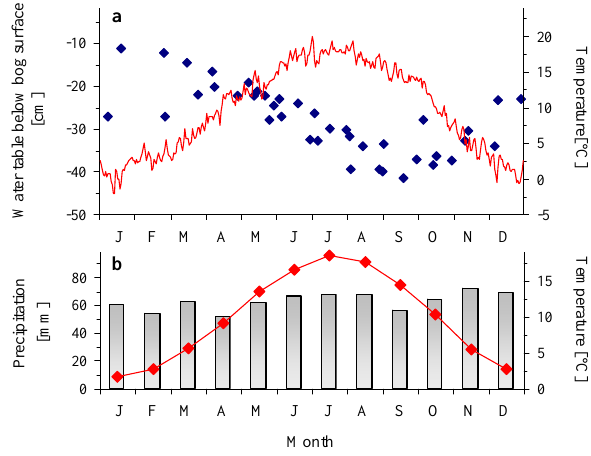
Fig. 8. Water table fluctuations in the centre of D¨urres Maar (dark blue diamonds) in combination with average daily temperatures (a) and monthly sum of precipitation in combination with average monthly temperatures (1961–1990) (b) . Water table fluctuations were measured from April 1991 until December 1993 by Forst et al. (1996). The depicted average daily temperatures for the years 1991, 1992 and 1993 were recorded at the meteorological station Manderscheid approximately 6 km to the south of D¨urres Maar op- erated by the German Meteorological Service. Also the monthly sum of precipitation and the average monthly temperatures of the time period from 1961 until 1990 were recorded at